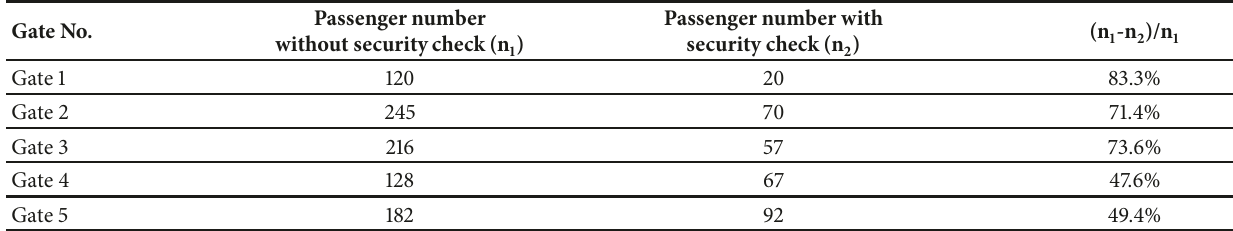
Table 5: Number of passengers entering each gate in 5 minutes.